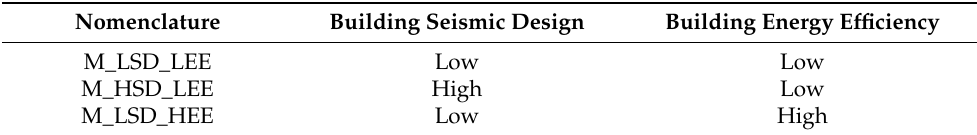
Table 5. Definition of masonry building typologies proposed for retrofitting